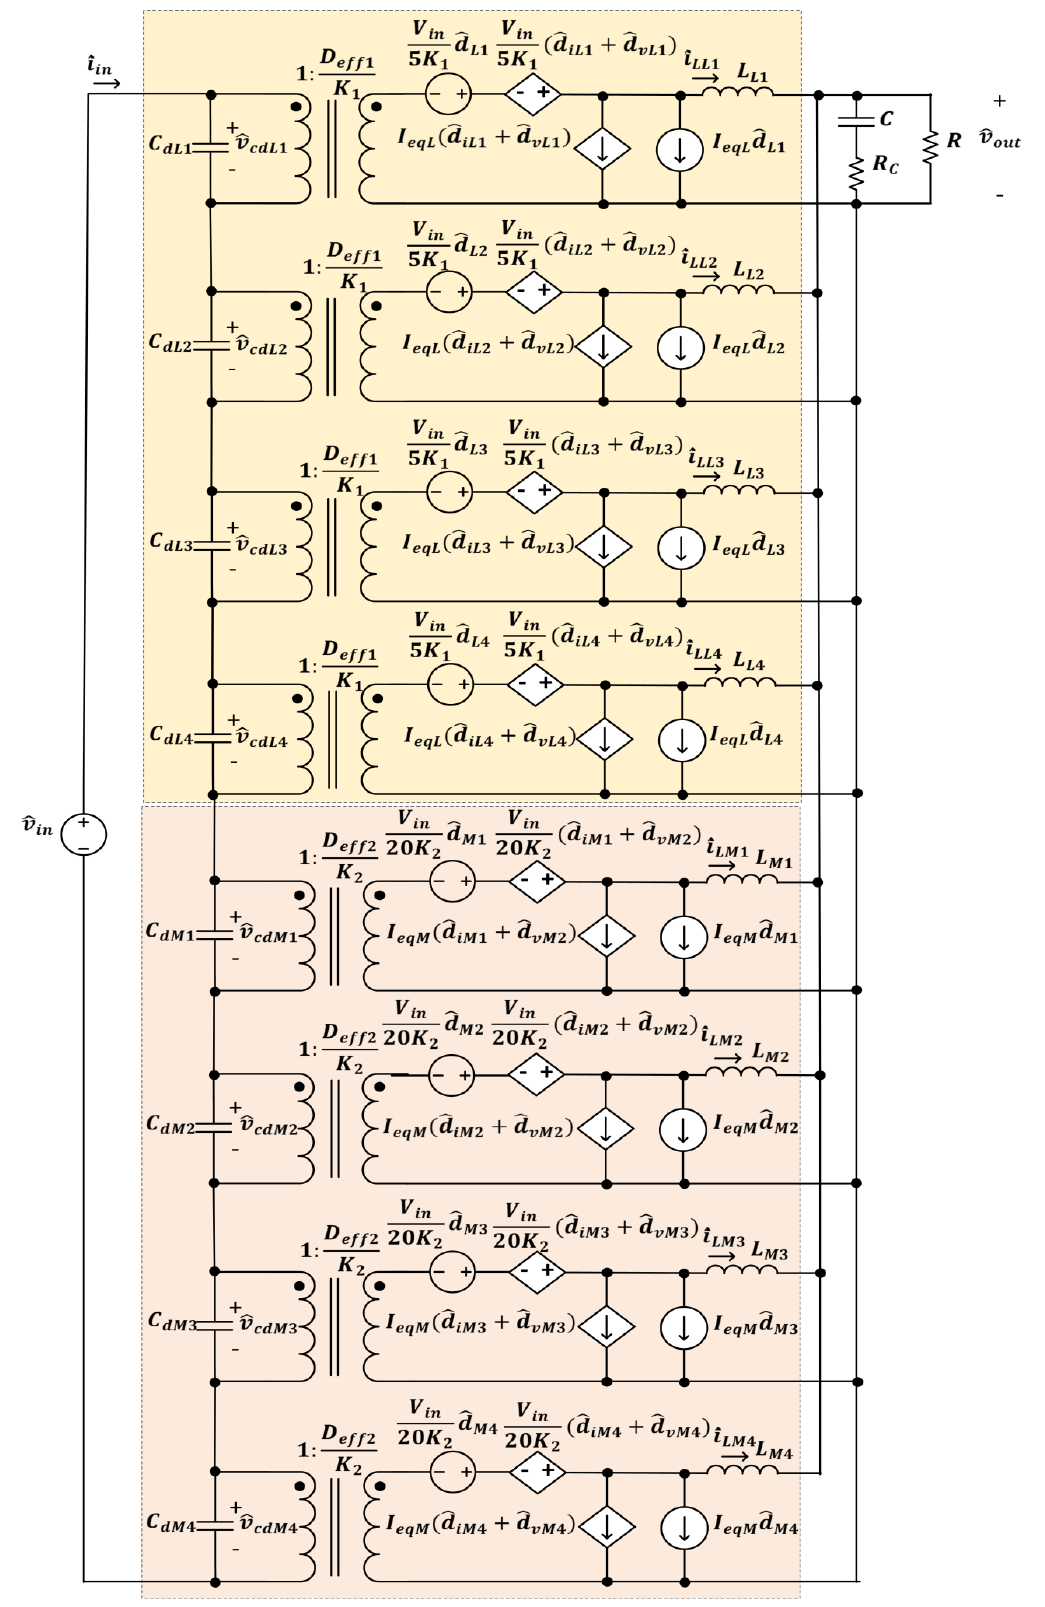
Figure 4. Small signal model for the generalized hybrid ISIP-OSOP multimodule DC-DC converter.